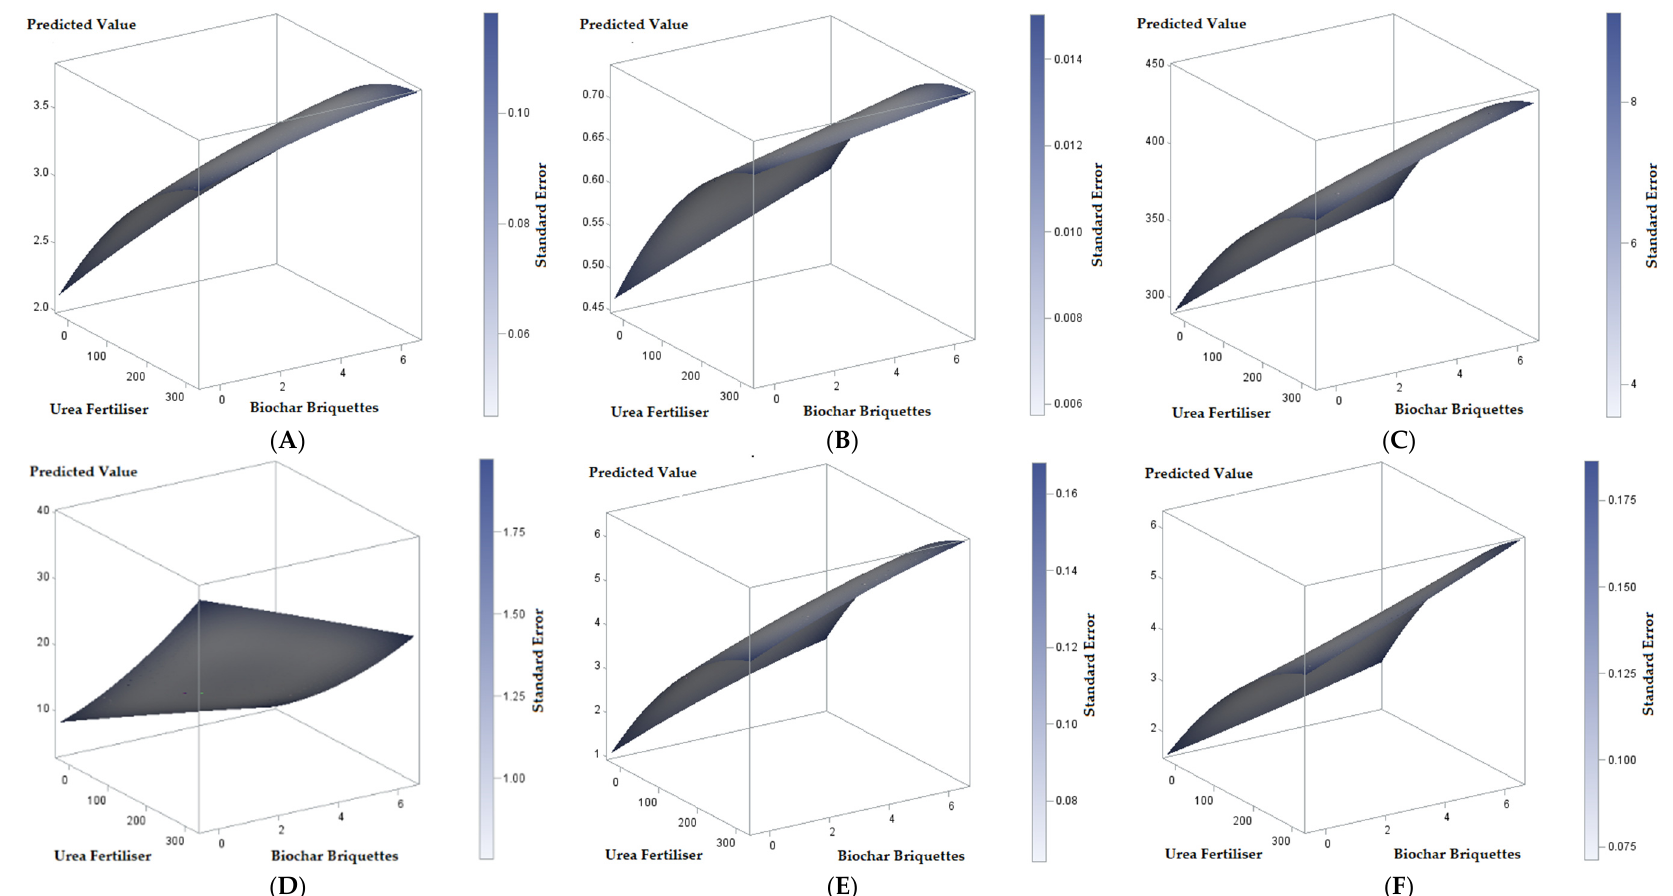
Figure 4. The response of physiological characteristics and yield of hybrid rice to in situ biochar briquettes (grain plant − 1 ) and urea fertiliser (kg ha − 1 ). ( A ) Nitrate reductase activity ( μ mol NO 2 − g − 1 h − 1 ), ( B ) Total chlorophyll (g g leaf − 1 ), ( C ) Leaf photosynthesis rate (CO 2 m − 2 s − 1 ), ( D ) Nitrogen loss (kg ha − 1 ), ( E ) Nitrogen-use efficiency (kg grain kg N fertiliser − 1 ), and ( F ) Yield of hybrid rice (tonnes ha − 1 ).